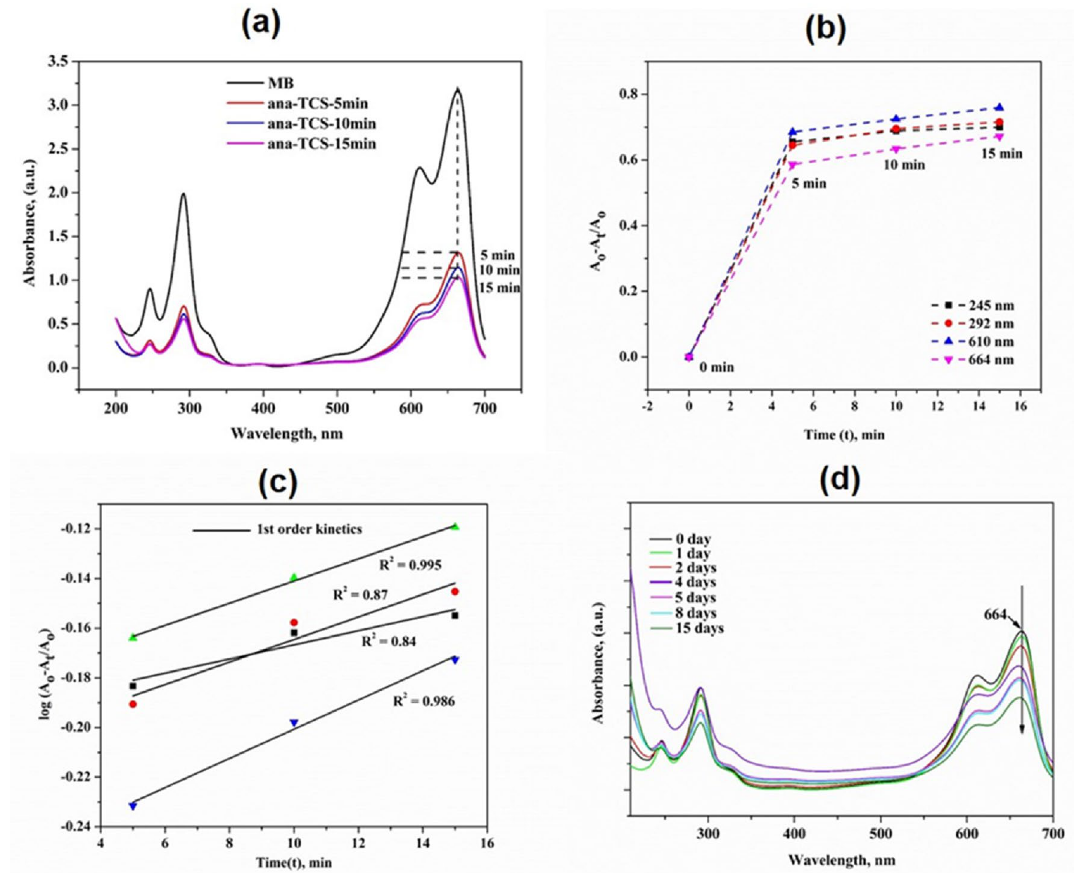
Figure 7. ( a ) Photocatalytic activity of ana-TCS in organic dye (MB), ( b ) Discoloration plot showing absorbance change with time, ( c ) Pseudo-first order kinetics for the 664 nm peak wherein R 2 ⁓ 1, ( d ) MB discoloration plot for the PLLA/ana-TCS nanocomposite with time for the peaks 610 nm and 664